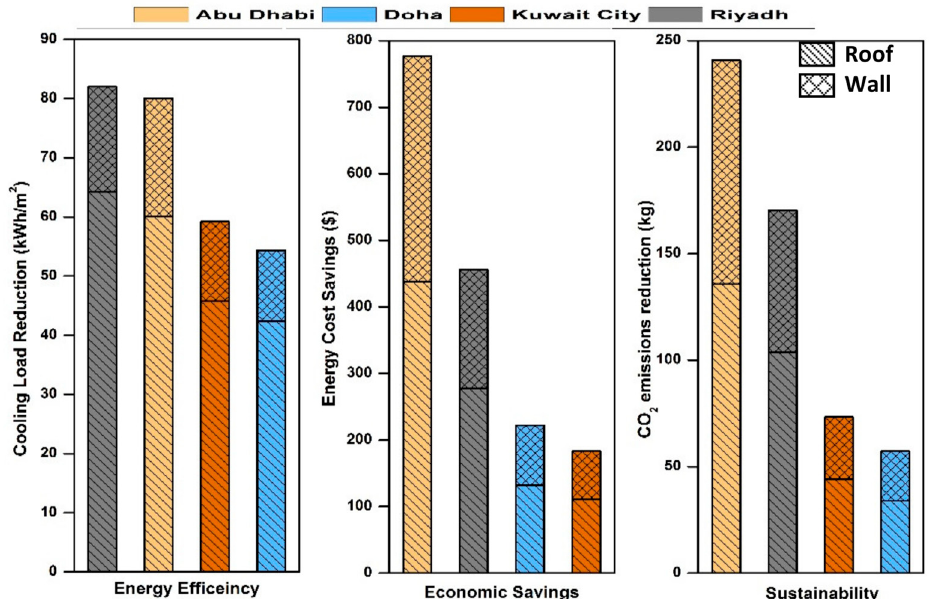
Figure 23. Charts depicting the first 3-year energy efficiency (left), cost savings (middle), and CO 2 emission reductions of cool paints retrofitting in selected GCC locations in descending